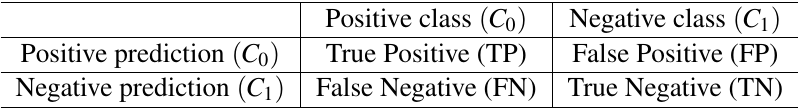
Table 1: Confusion matrix for two classes